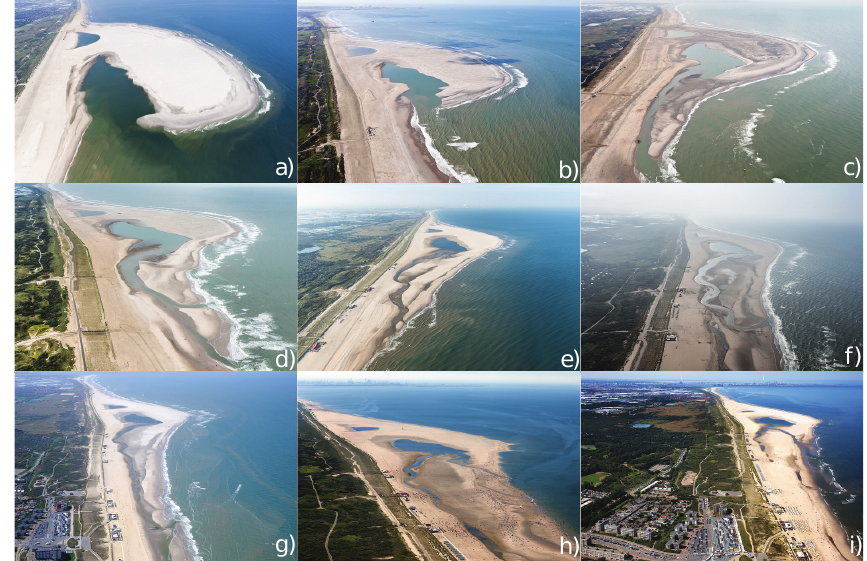
Figure 1. Aerial pictures of the first concentrated mega-nourishment (ZM, The Netherlands), showing its morphological evolution in the initial six years. Pictures were taken in: ( a ) July 2011 (shortly after construction); ( b ) October 2011; ( c ) January 2012; ( d ) October 2012; ( e ) October 2013; ( f ) September 2014; ( g ) May 2015; ( h ) August 2016; and ( i ) July 2017. Courtesy: Rijkswaterstaat, Joop van der